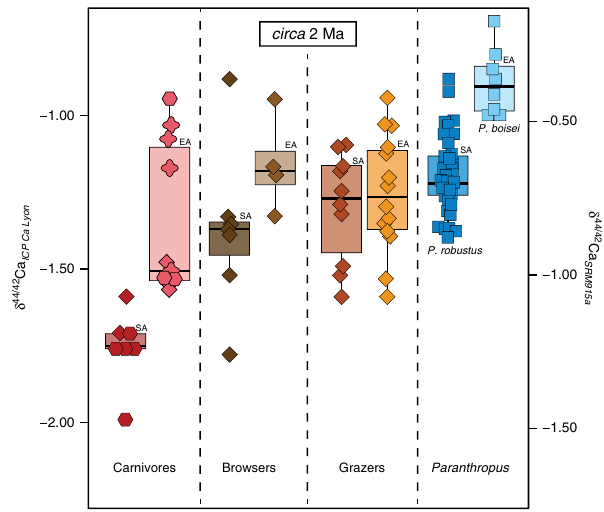
Fig. 3 Box and whisker plots showing the distribution of δ 44/42 Ca values (in ‰ ) between Turkana Basin Paranthropus boisei , South African Paranthropus robustus 33 and associated mammal faunas. Data for grazers, browsers, and carnivores are from Martin et al. 29 and Tacail et al. 33 . EA East Africa, SA South Africa. Values selected for representatives of the associated-fauna include only those values for organisms circa 2 Ma; for this reason, the browser category may appear underrepresented and the apparent difference may re fl ect speci fi c dietary differences rather than differences in the substrate isotope baseline. Note that carnivore values in EA are dispersed as explained by a dataset that includes sabertooth felids. The boxes represent the fi rst and third quartiles with the medians as horizontal lines. The lower and upper whiskers represent 1.5 * the interquartile range (numbers of biologically independent samples per group: n = 7 for South African carnivores; n = 10 for East African carnivores; n = 7 for South African browsers; n = 4 for East African browsers; n = 10 for South African grazers; n = 14 for East African grazers; n = 38 for Paranthropus robustus ; n = 8 for Paranthropus boisei ). δ 44/42 Ca values are expressed both against ICP Ca Lyon (left) and SRM915a (right). Source data are provided as a Source Data fi